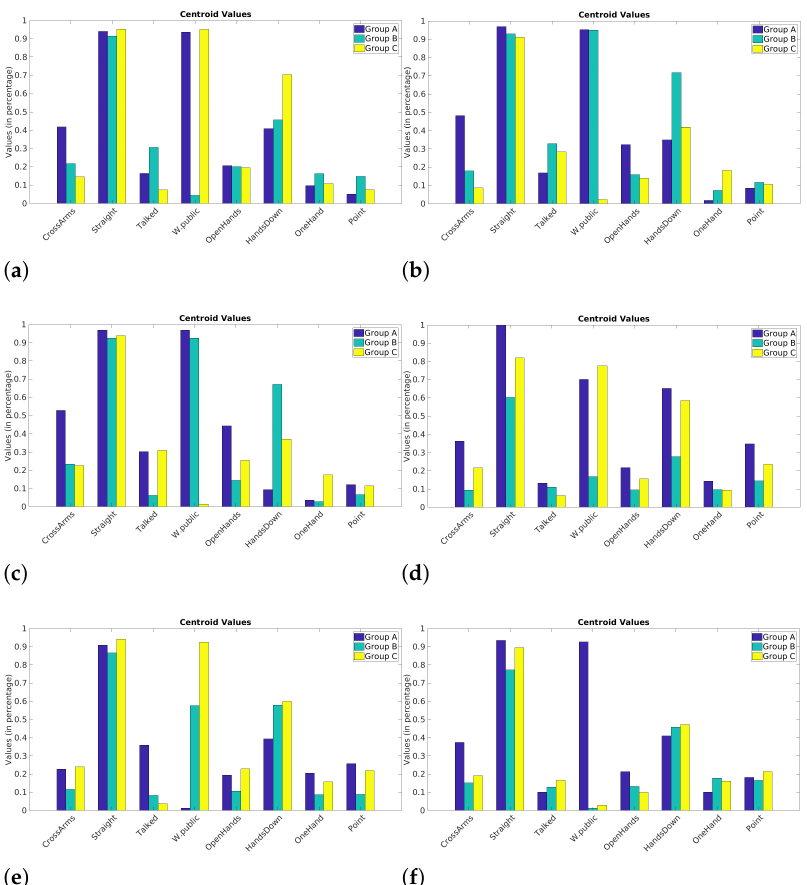
Figure 6. Bar charts of the centroids for each presentation. ( a ) P1 year 1, ( b ) P2 year 1, ( c ) P3 year 1, ( d ) P1 year 2, ( e ) P2 year 2, ( f ) P3 year